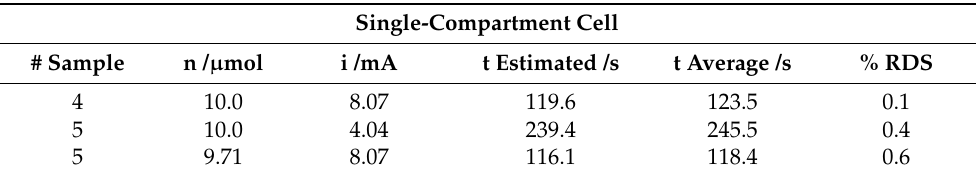
Table 3. The results for standard potassium acid phthalate 0.05 M